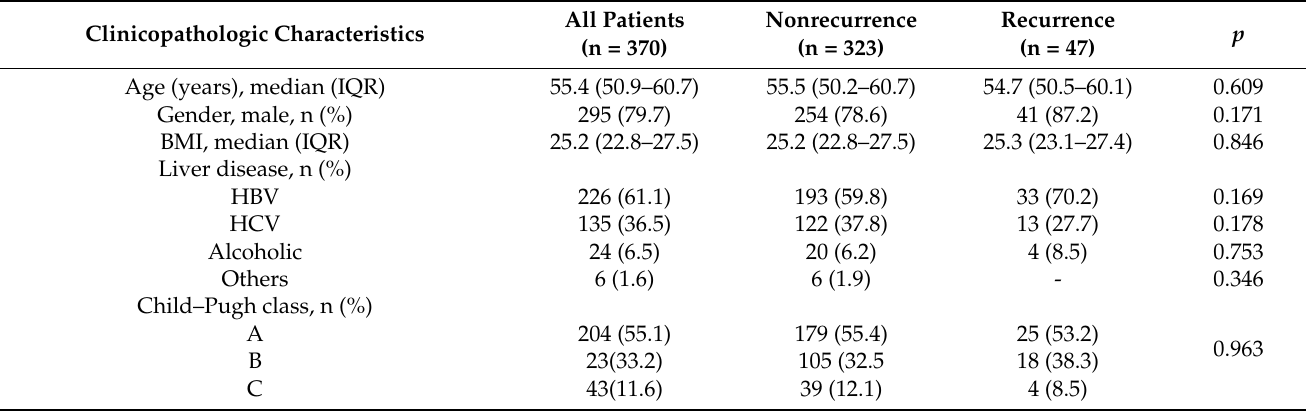
Table 1. Clinicopathologic characteristics of patients associated with tumor recurrence after living donor liver